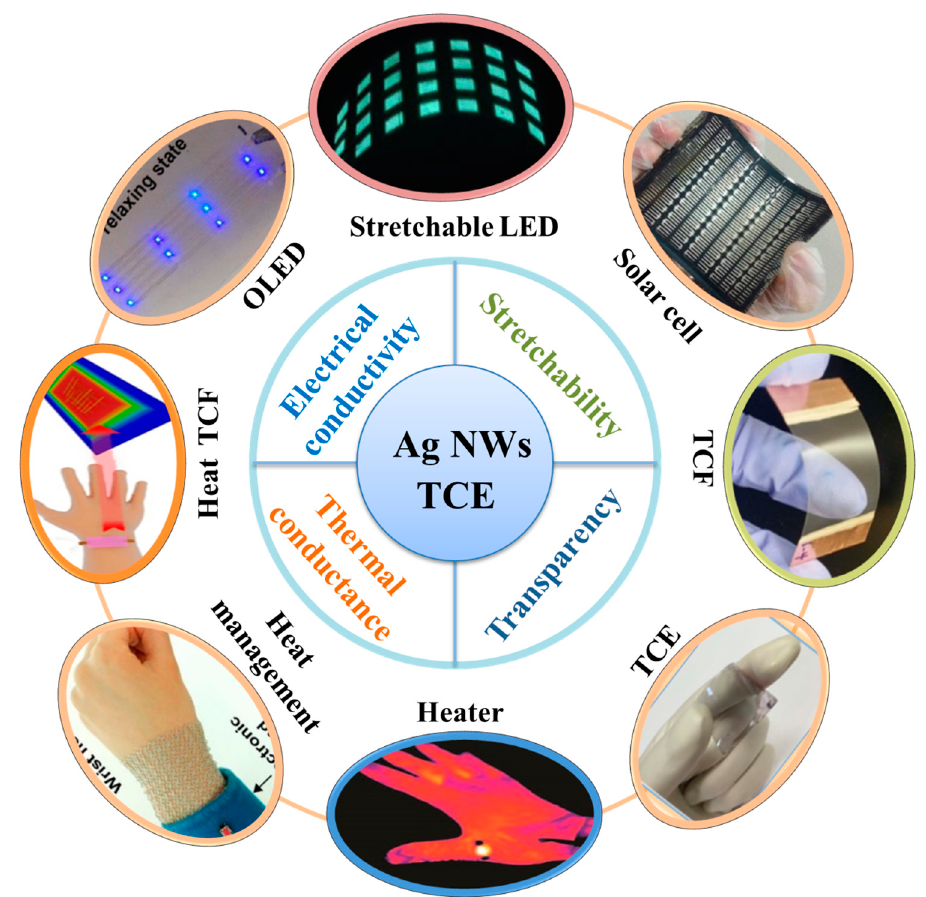
Figure 1. Properties and applications of recently developed devices based on Ag NWs TCE. “Heat